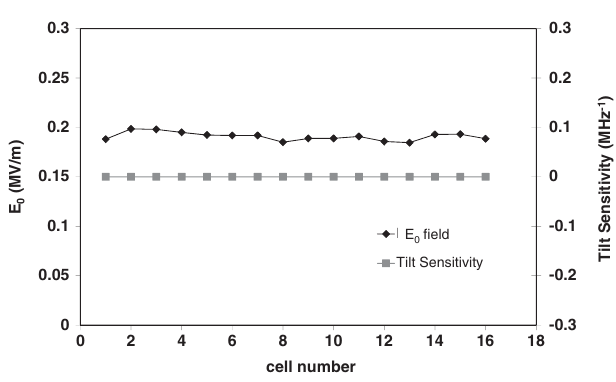
FIG. 26. Reference field and tilt sensitivity.